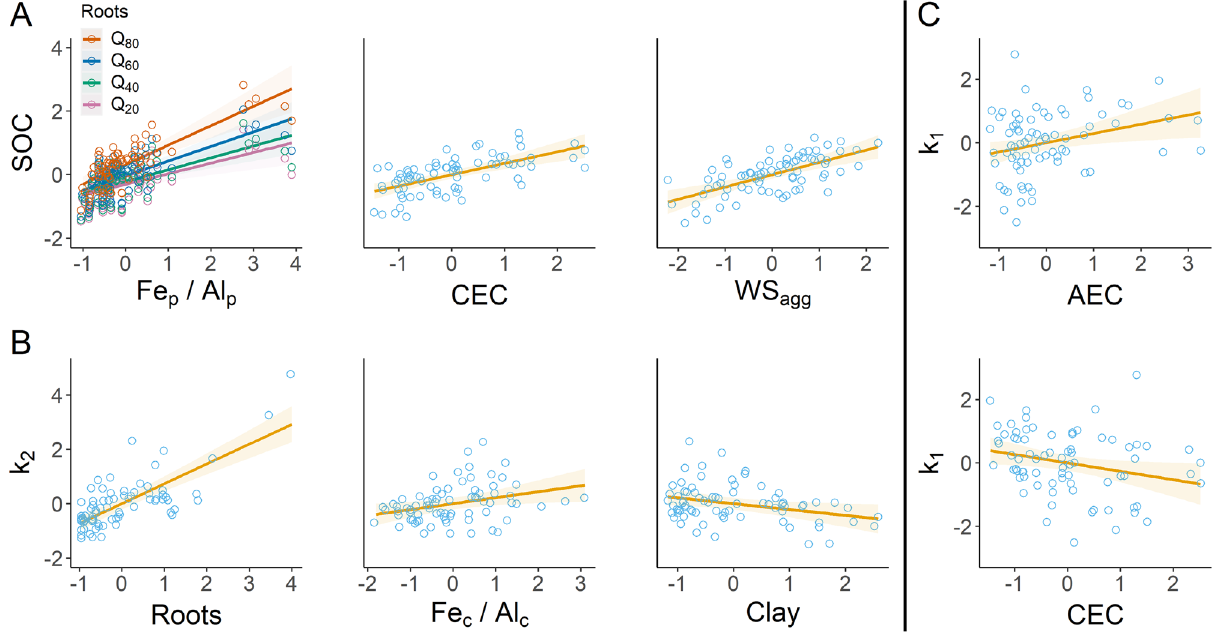
Figure 4. Partial regression plots of C response predicted by physicochemical soil properties across 20 field locations sampled by horizon to 1 m. Models with the highest marginal R 2 after model selection by AICc are visualized for each C response variable: SOC content ( A ), the slow pool decay rate, k2 ( B ), and the fast pool decay rate, k1 ( C ). All data were mean-centered and scaled by relative standard deviation for comparison. Regression coefficients are shown as fitted lines with 95% confidence